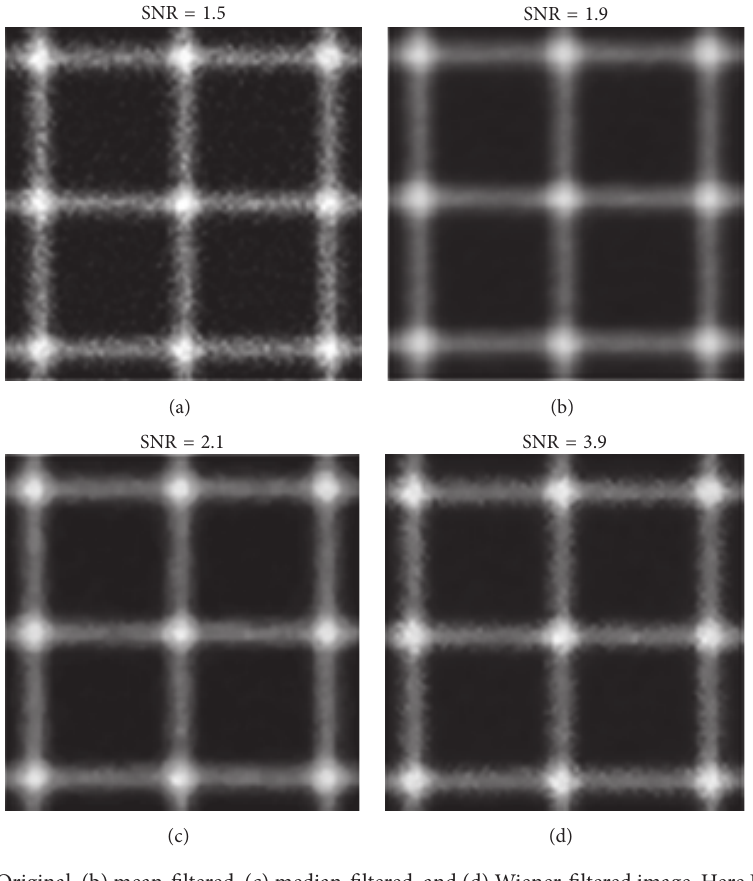
Figure 3: (a) Original, (b) mean-filtered, (c) median-filtered, and (d) Wiener-filtered image. Here LW = 9 pixels.